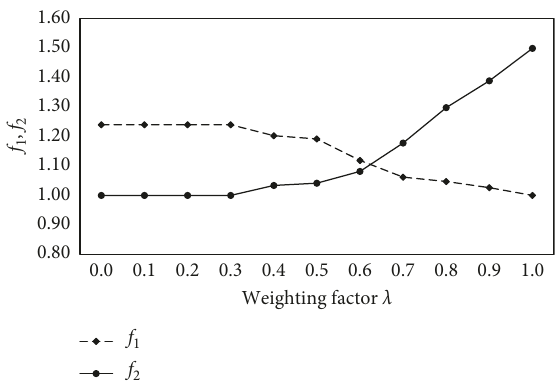
Figure 8: Solutions of f 1 and f 2 with various values of weighting factor λ for Test Network-2.